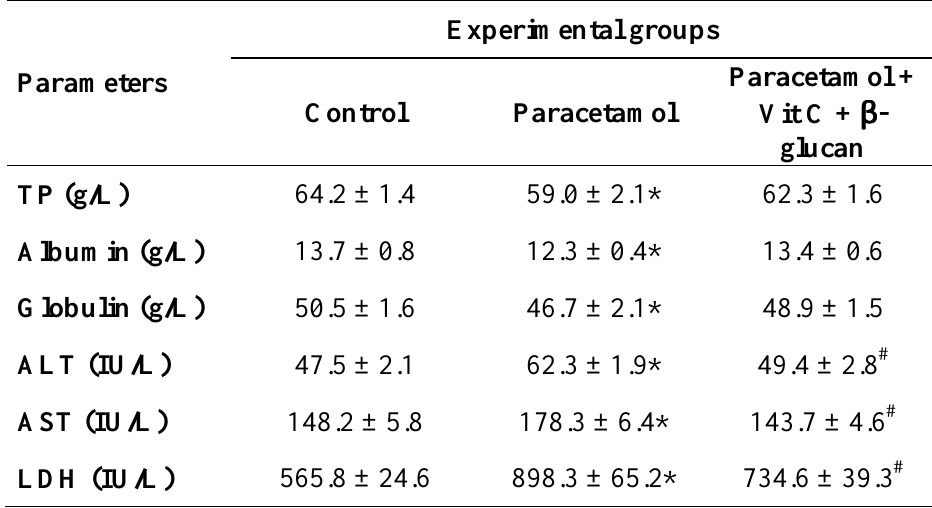
Table 2. Effects of vitamin C and b -glucan on biochemical parameters in serum of paracetamol-treated rats.